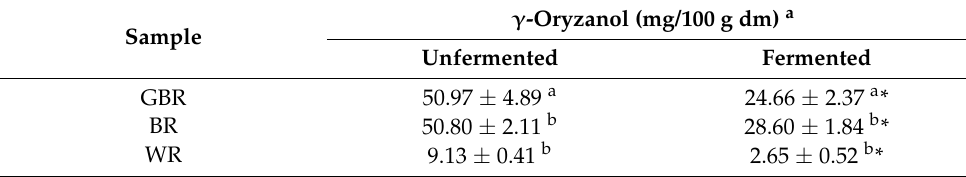
Table 4. Effect of fermentation on the γ -oryzanol contents of rice